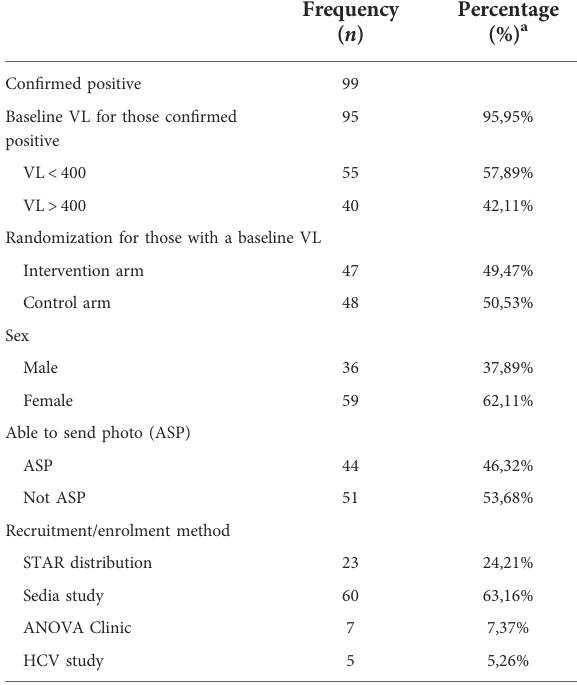
TABLE 3(B) Con fi rmed positive